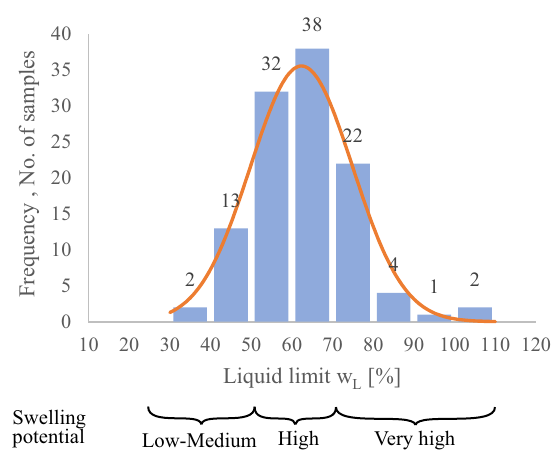
Fig. 9 Histogram of the samples Liquid limit (w L ) and swelling potential according to (Dakshanamurthy and Raman 1973)